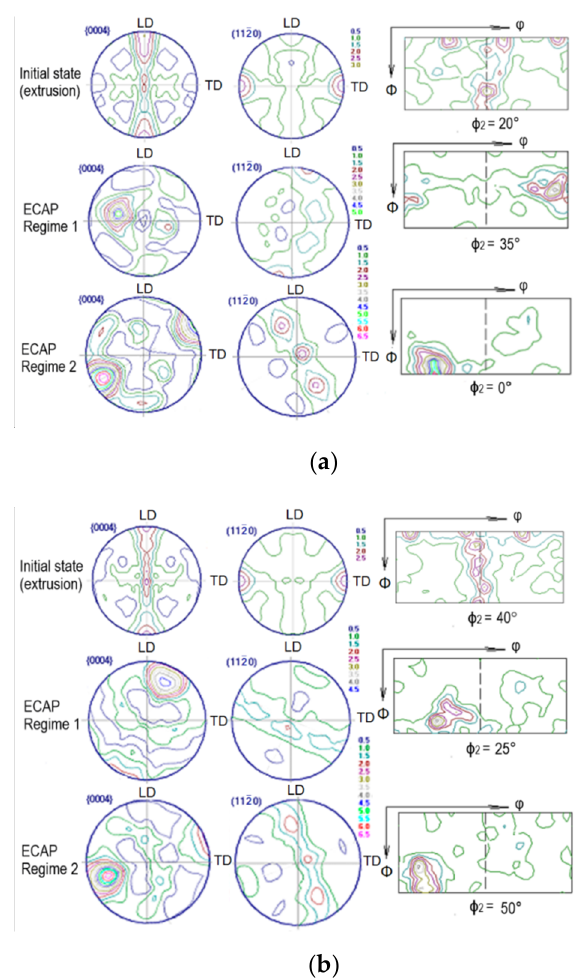
Figure 4. {0004} and {1120} pole figures and cross sections of orientation distribution function (ODF) of Mg-2.0%Ag ( a ) and Mg-4.0%Ag ( b ) alloys in the initial state and after ECAP (LD-longitudinal direction, TD-transverse direction).